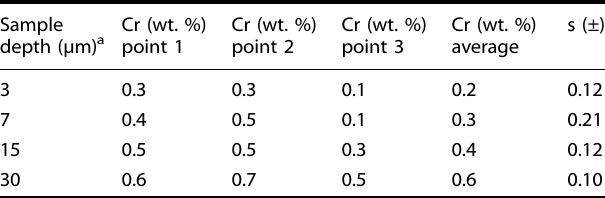
Table 3. Concentration of Cr at different sample depths for 50TiO 2 fi lm exposed in aqueous Na 2 CrO 4 solution for 14 days at 60 °C. Sample Cr (wt. %) depth (µm) a point 1